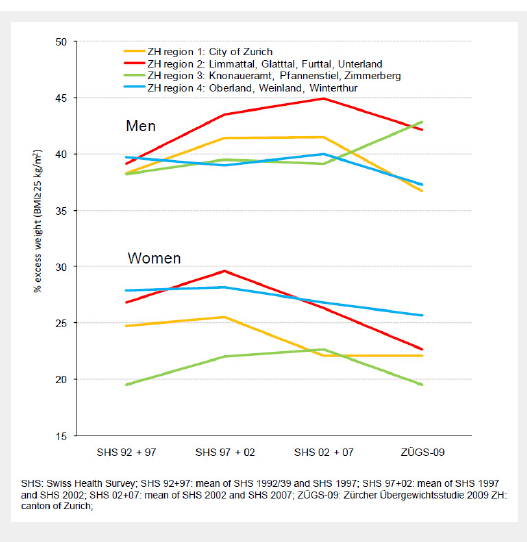
Age standardised and population weighted prevalence (% with 95% confidence interval) of excess weight by region and sex, 1992–2009, men and women aged 18–74 years (n = 41628).